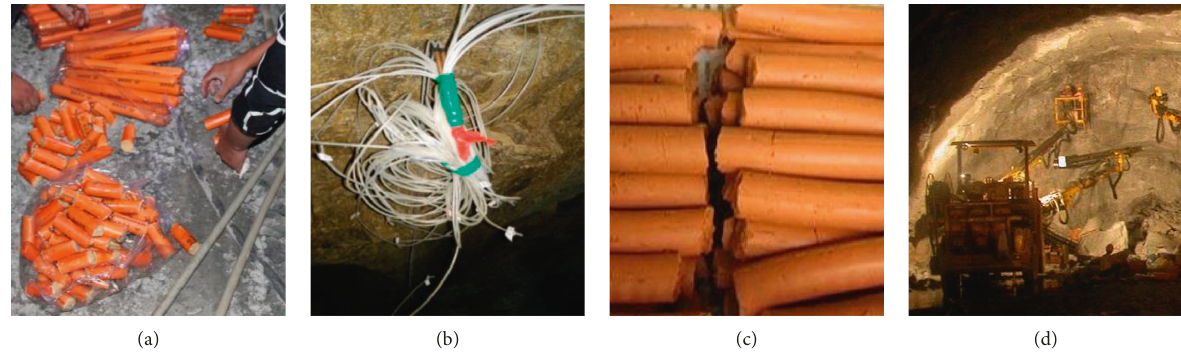
Figure 6: Relevant materials and instruments of field tests. (a) Explosive. (b) Detonator. (c) Stemming. (d)